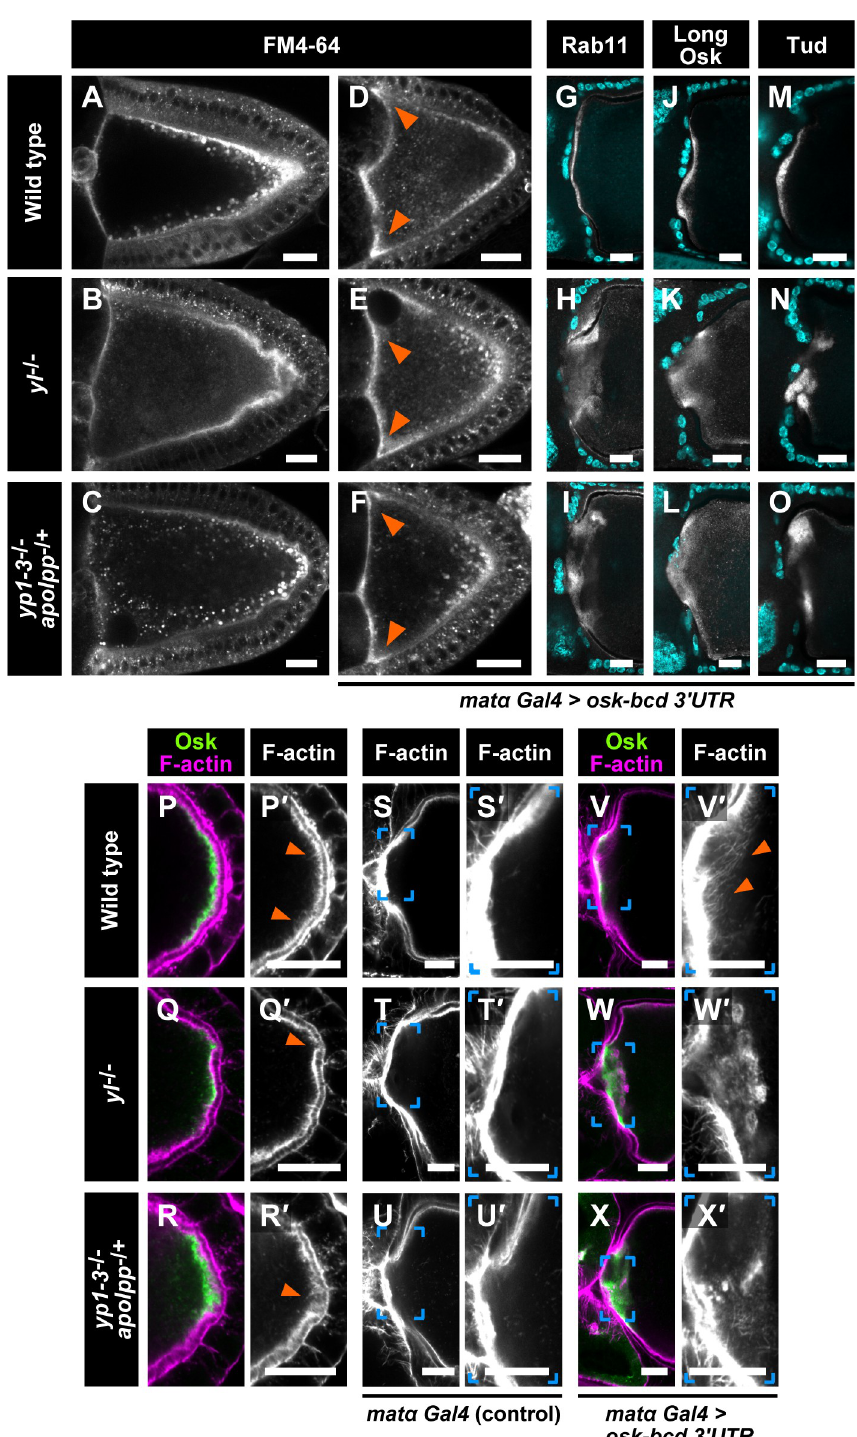
Fig 4. Osk-mediated actin remodeling and cortical anchorage of germ plasm components depend on Yl and its ligands. (A–C) Internalized FM4-64 dye in stage 10a oocytes. Wild-type oocytes showed strong FM4-64 signals concentrated at the posterior pole (A). In contrast, yl −/− (B) and yp1–3 −/− apolpp −/+ (C) oocytes displayed reduced FM4-64 uptake at the lateral and posterior regions. However, the posterior enrichment of FM4-64 signals remained in these mutant oocytes. Note that in yl −/− oocytes, the signals appeared as smaller vesicular compartments. (D–F) Stage 9 osk-bcd 3 0 UTR oocytes cultured in the presence of FM4-64. Arrowheads indicate ectopic FM4-64 uptake in